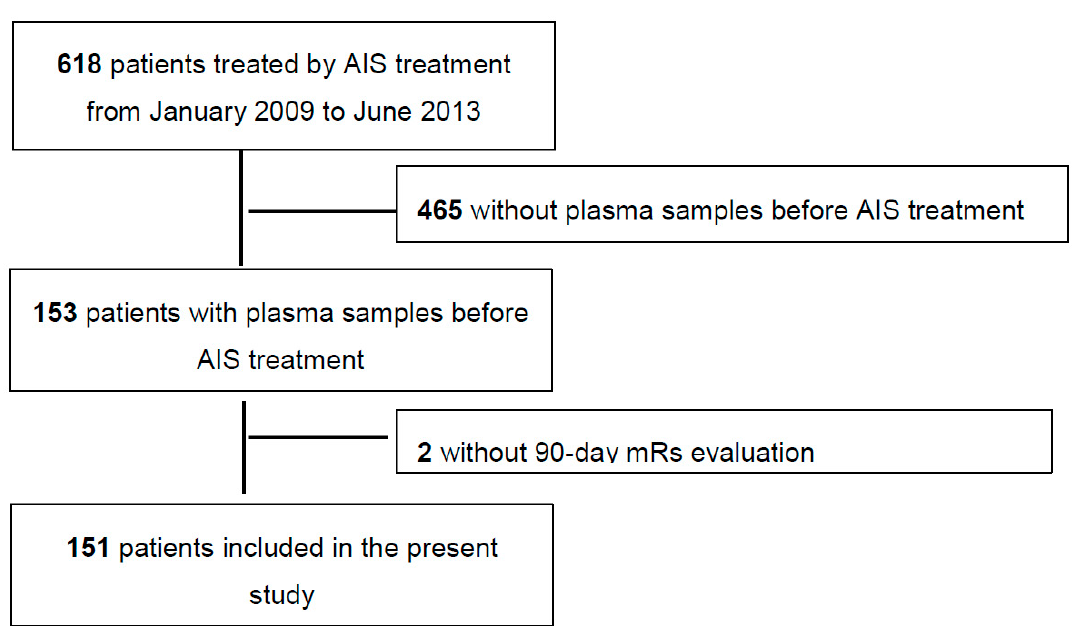
Figure 1. Study flow-chart. AIS = Acute ischemic stroke.